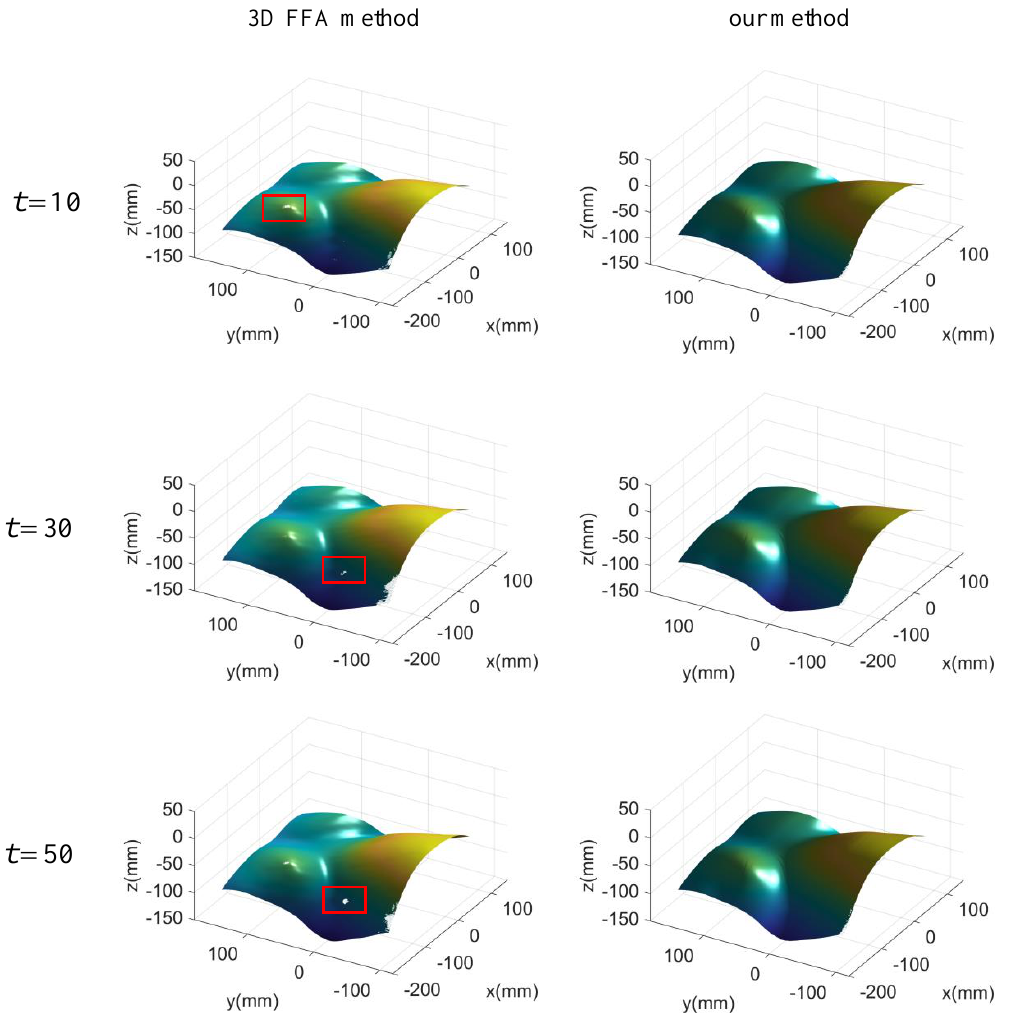
Figure 8. Thoracic and abdominal surface 3D reconstruction result of three different times with dif- ferent method.